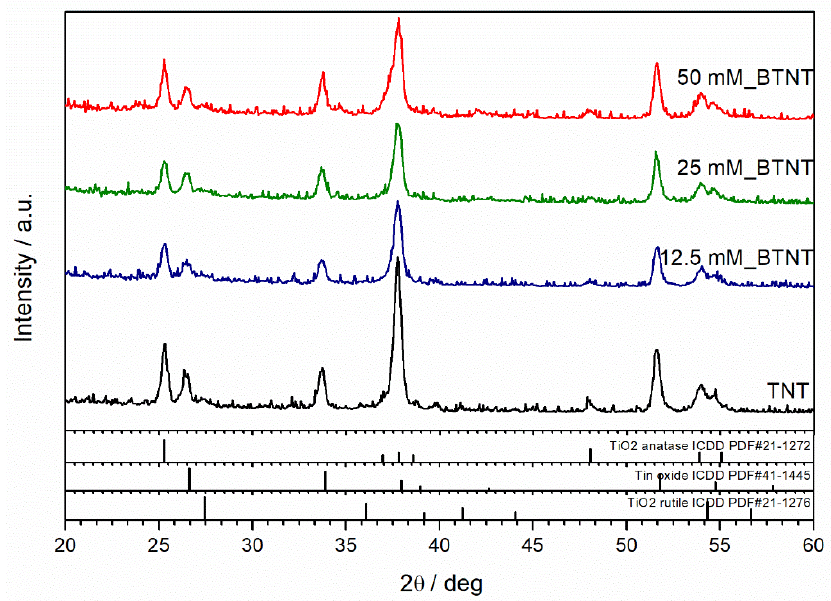
Figure 3. XRD diffractograms for Ba-modified TNT samples (12.5, 25.0, 50.0 mM).